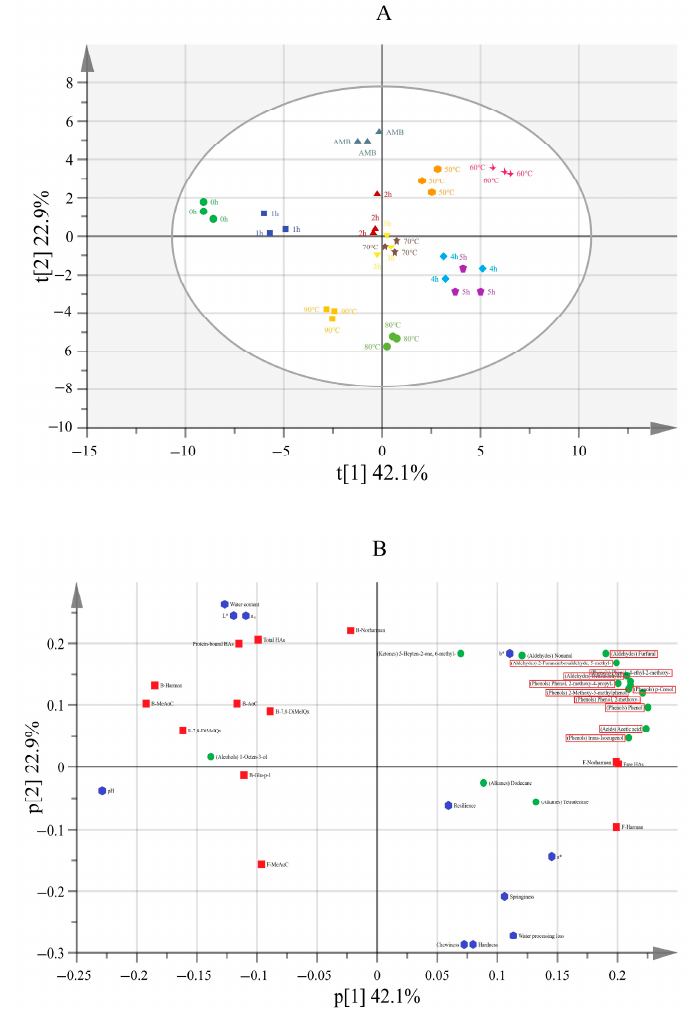
Figure 5. Scores ( A ) and loadings ( B ) scatter plot of PCA analysis of smoked meat, treated under different smoking durations and temperatures. AMB represents ambient temperatures.